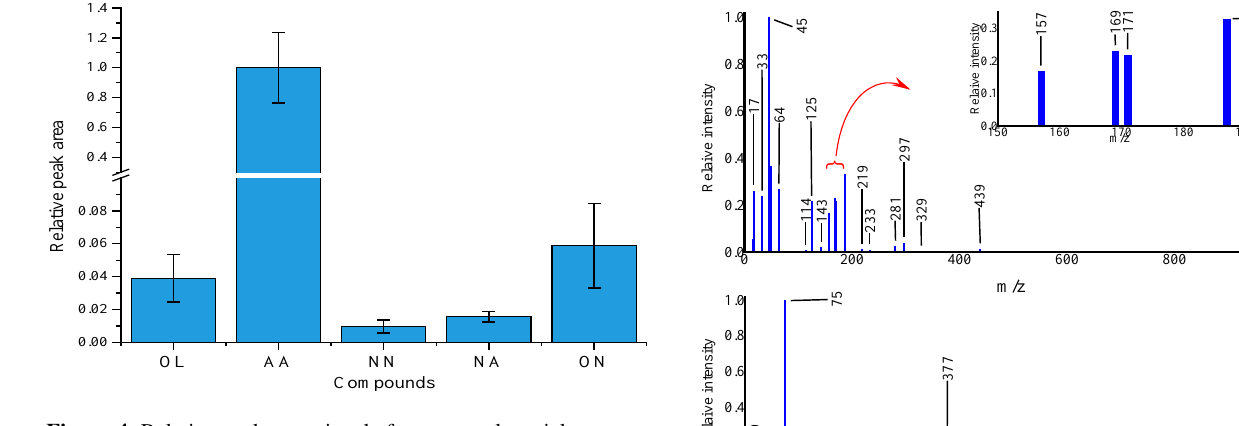
Figure 4. Relative peak area signals from aerosol particles gener- ated from an equimolar mixture of OL, AA, NA, NN, and 4-ON. Peak areas are an average from 200 mass spectra.